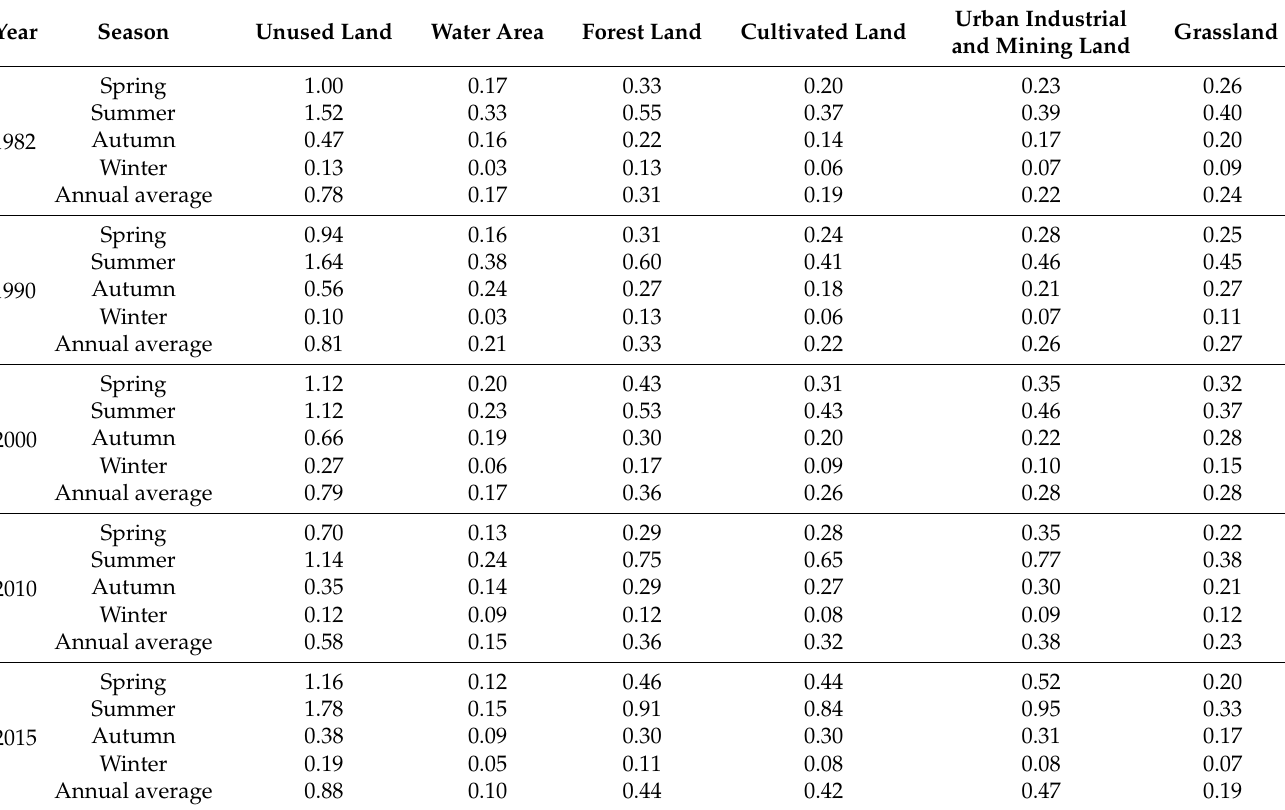
Table 4. Seasonal and inter-annual variation of T:E values of different land-use